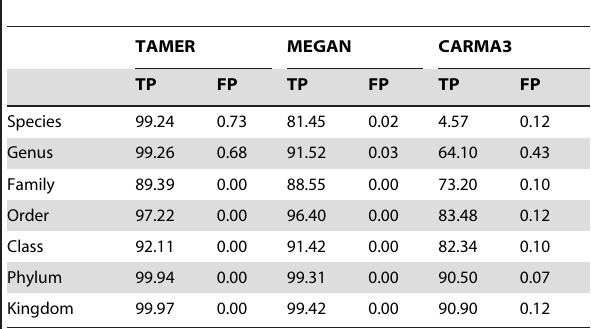
Table 2. Results for CARMA3 evaluation dataset.